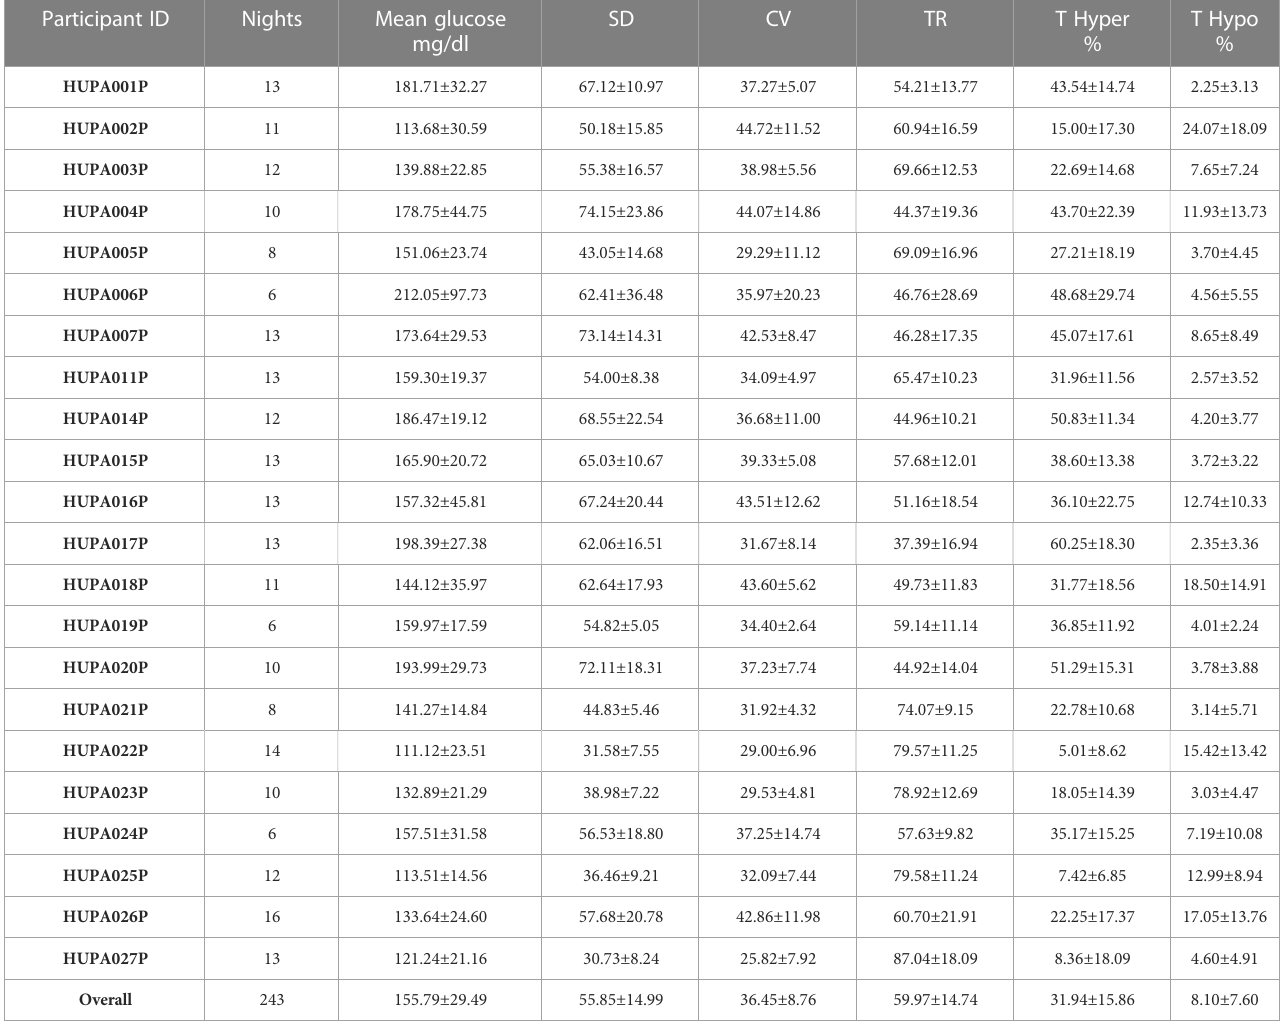
TABLE 6 Overnight glycemic characteristics in individual participants. Participant